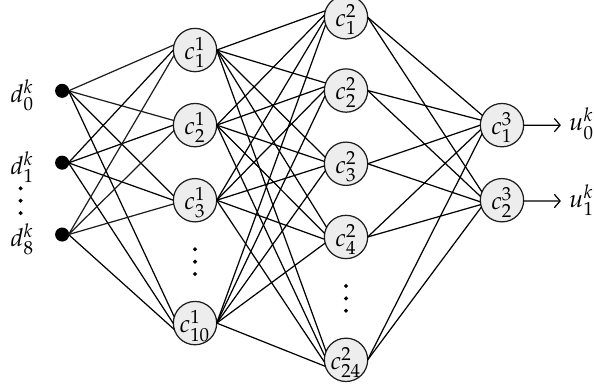
Figure 5. General structure of the proposed